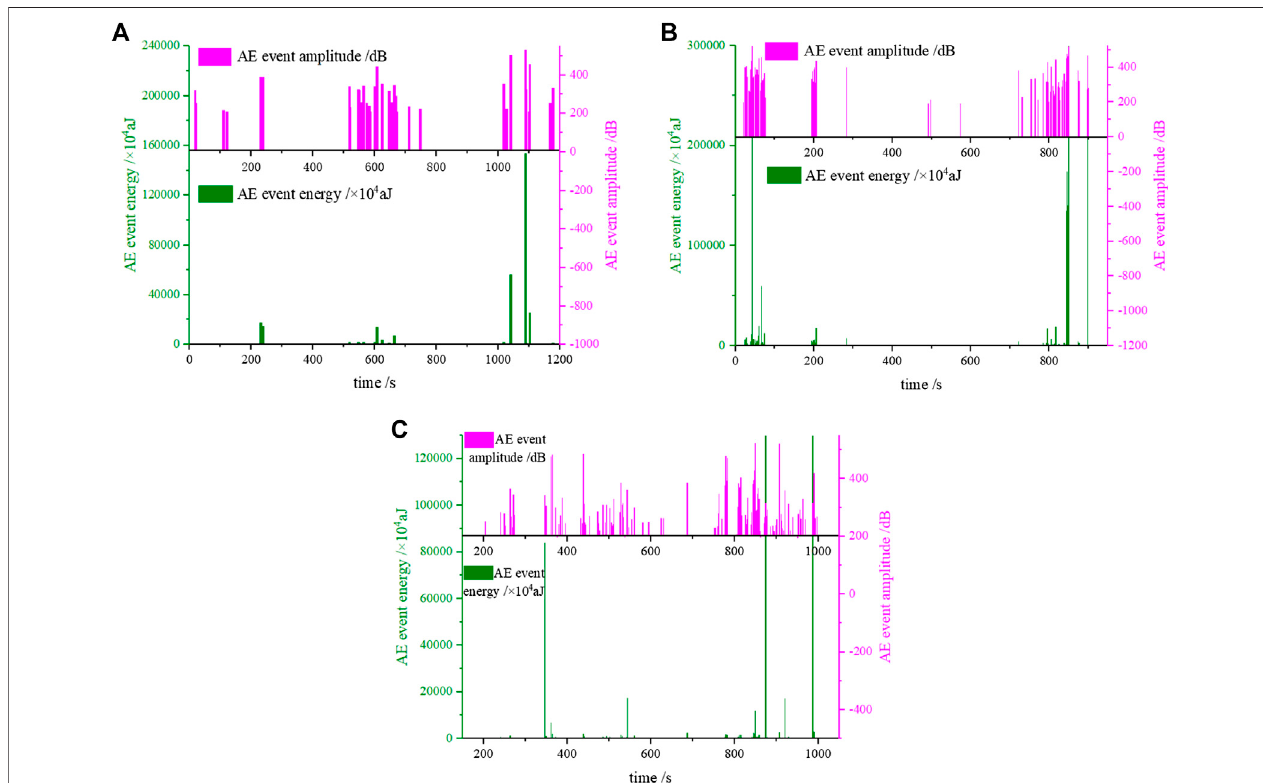
FIGURE 9 | The distribution of AE event amplitude and energy under different loading rates. (A) v (cid:2) 0.15 mm/min; (B) v (cid:2) 0.2 mm/min; (C) v (cid:2) 0.3 mm/min.